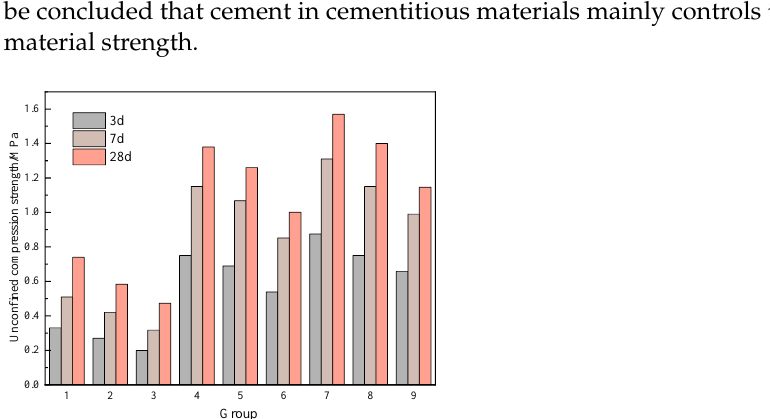
Figure 6. The wet density of the lightweight CLSM.